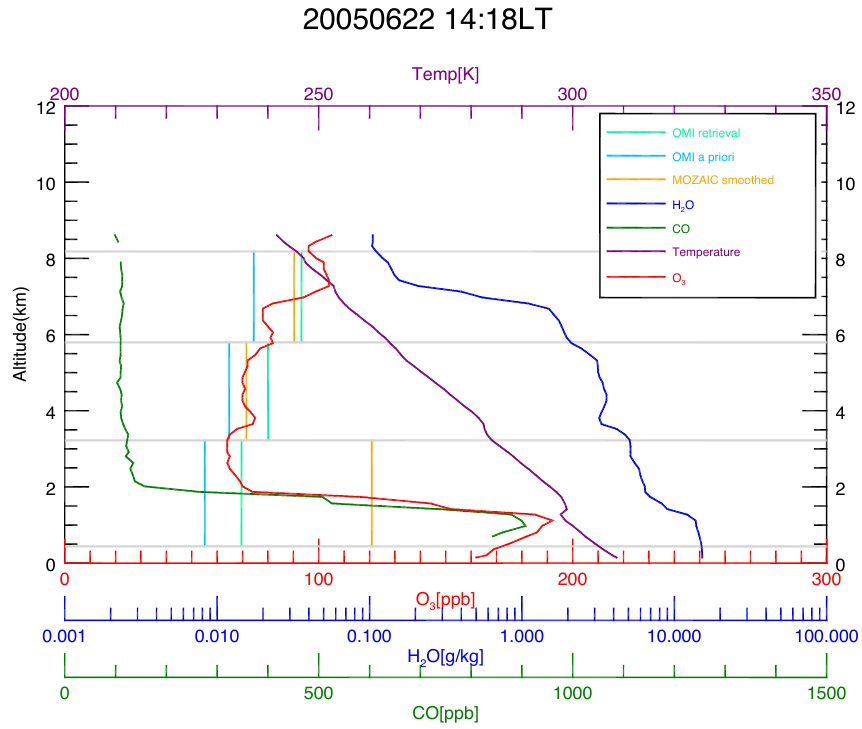
Figure 2. Vertical profiles of ozone (red), CO (green), H 2 O (blue), and temperature (purple) obtained by MOZAIC airborne measurements on 22 June 2005 at 14:18LT over Beijing. The scale of each parameter is shown in the same colors. The smoothed-MOZAIC ozone profile according to the corresponding OMI layers is shown by orange lines. Correspondingly, a priori and OMI-retrieved ozone are shown in light blue and light green, respectively. The OMI 22nd, 23rd, and 24th layers correspond to 6–8, 3–6, and 0–3km,